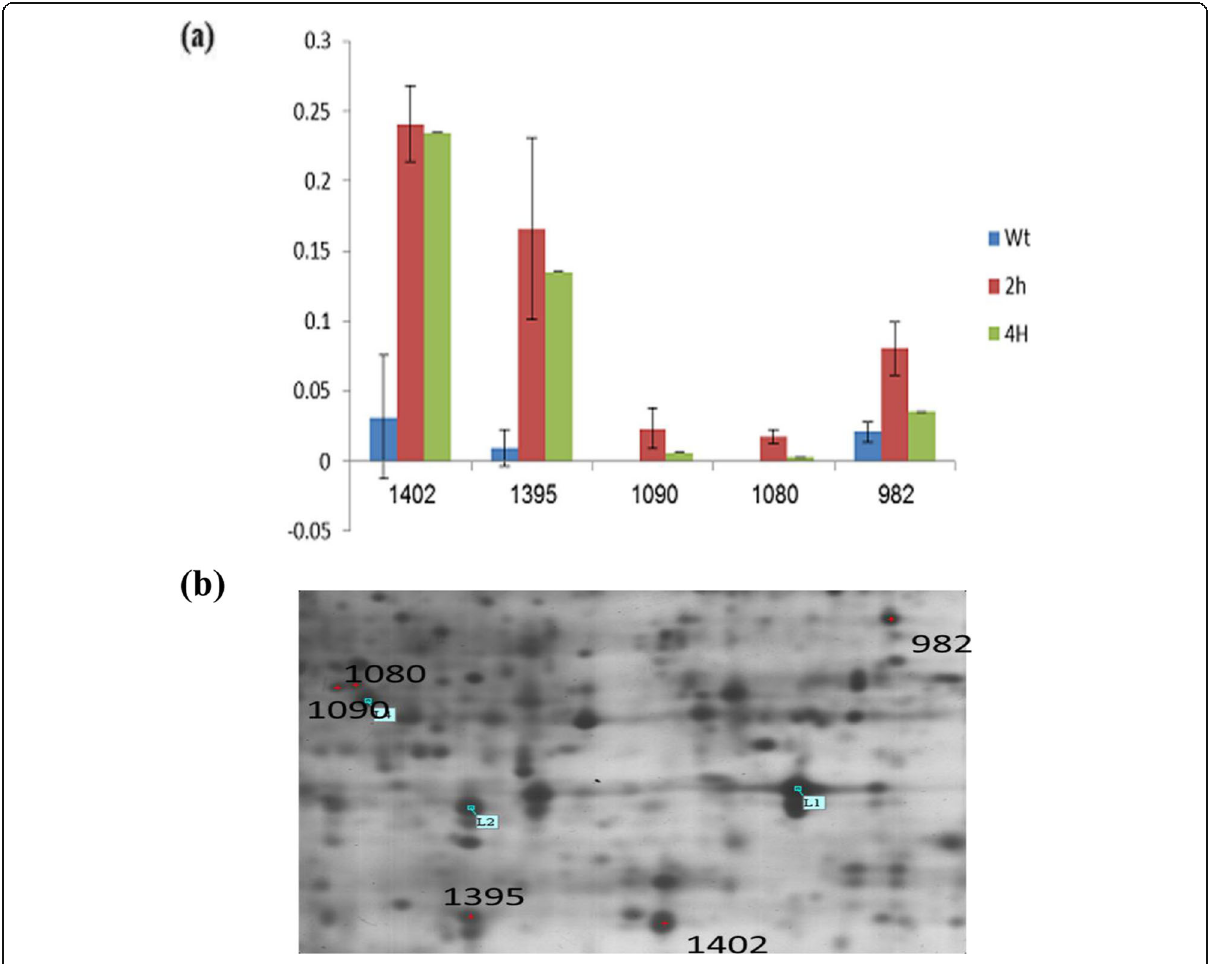
Fig. 5 Detail of the differential intensities of chosen spots in response to heat treatment ( a ). Spots were chosen for LC-MSMS analysis ( b